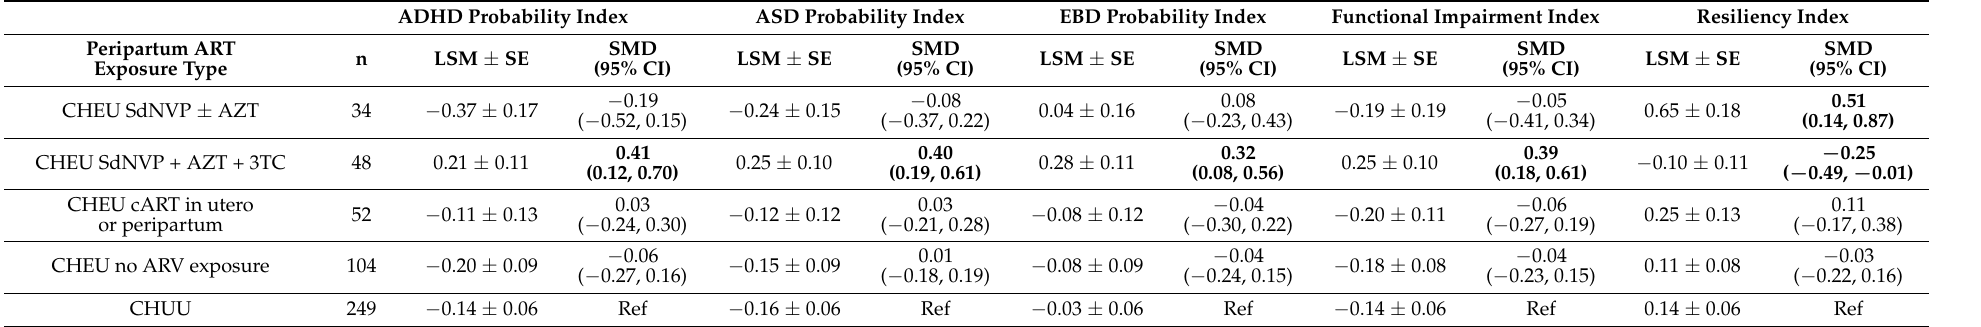
Table 3. Early-life ART exposure in relationship to ADHD, ASD, and EBD probability indices and overall resiliency among 6–18 years old HIV-exposed uninfected children relative to community control children from